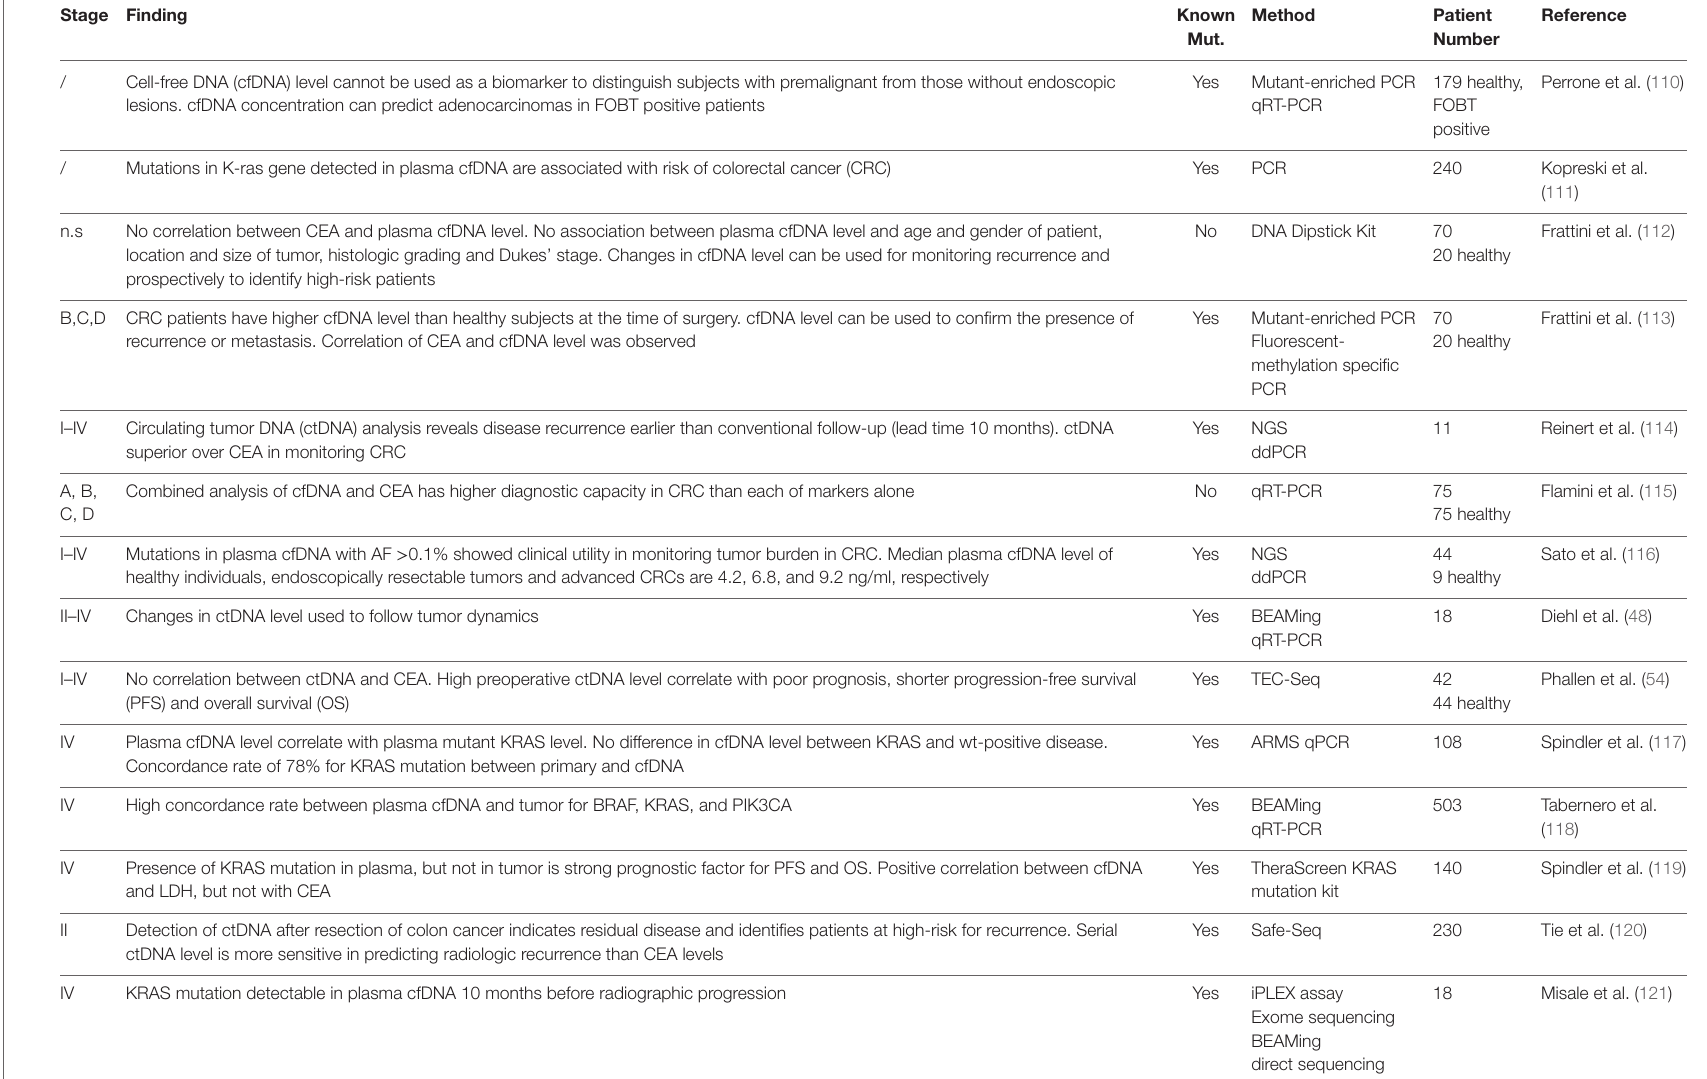
TABLe 3 | Colorectal cancer. Stage